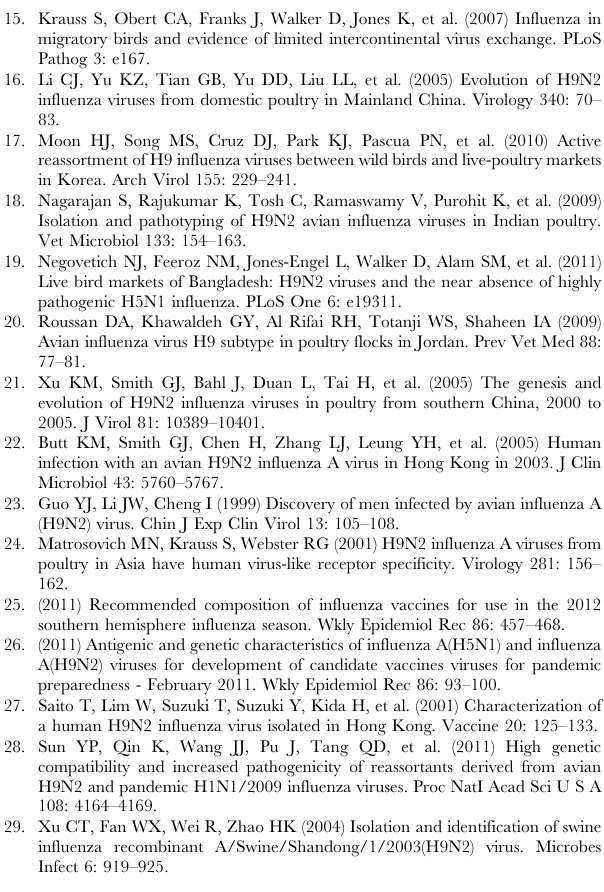
Figure S3 Phylogenetic distribution of 800 H9 subtype AIVs based the sequences of the HA1 subunit of the viral